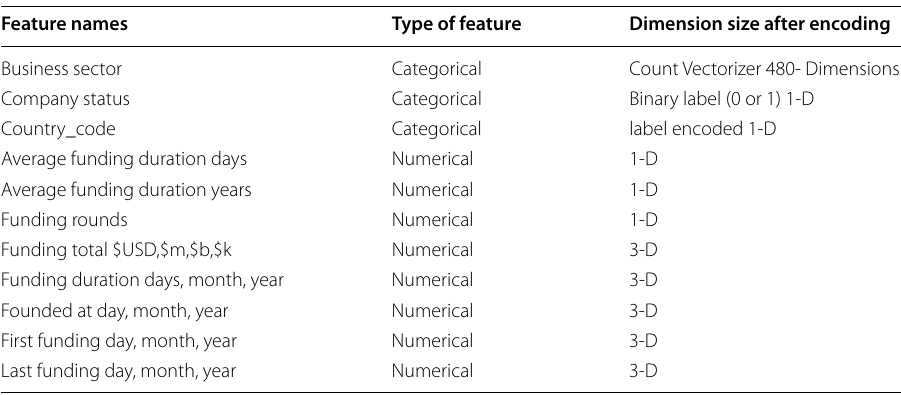
Table 6 Baseline